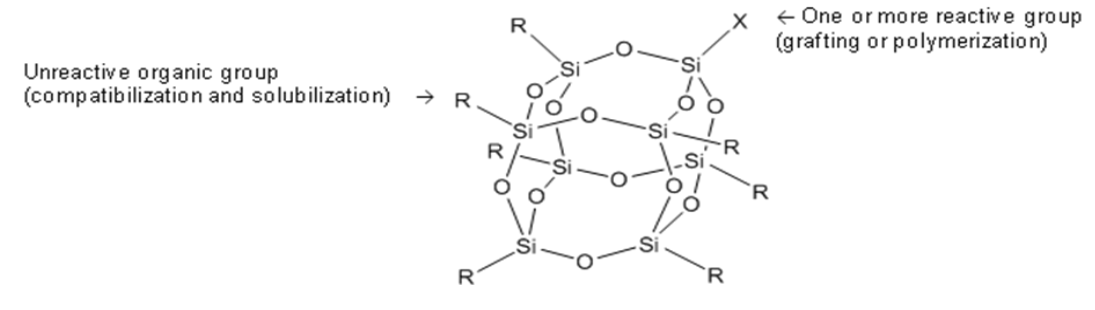
Figure 2. Structure of cage hexahedral silsesquioxane (RSiO